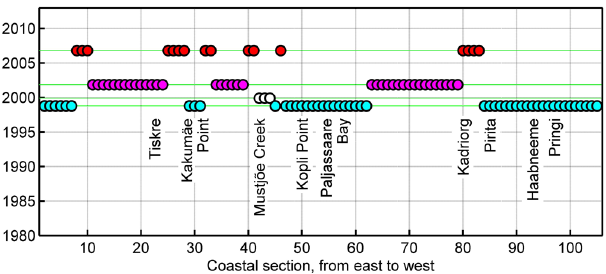
Fig. 6. The angle between the normal to the coast and wave ap- proach direction for the highest waves in the study area in 1981– 2012.